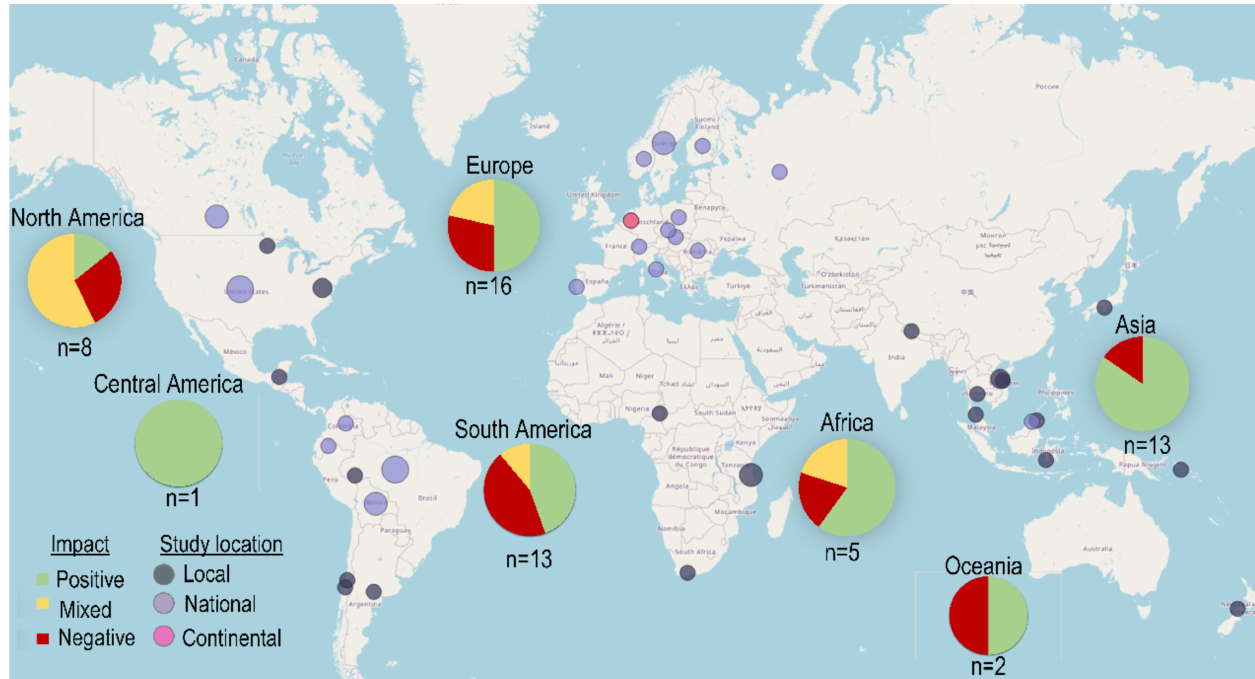
Figure 9. Impact of forest certification on economic viability, presented by indicator and number of case studies.